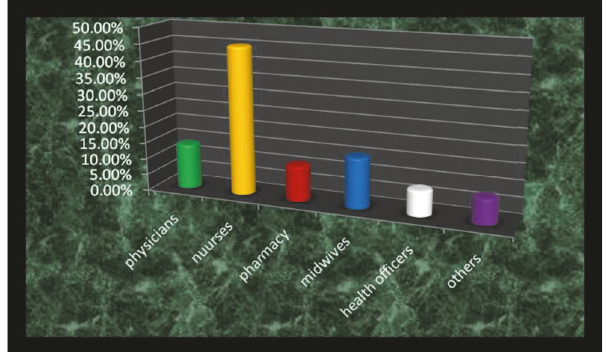
Figure 2: Frequency distribution of study participants by pro- fession, Dubti Referral Hospital, April 2016. Others : laboratory technicians, radiologists, and anesthetists.